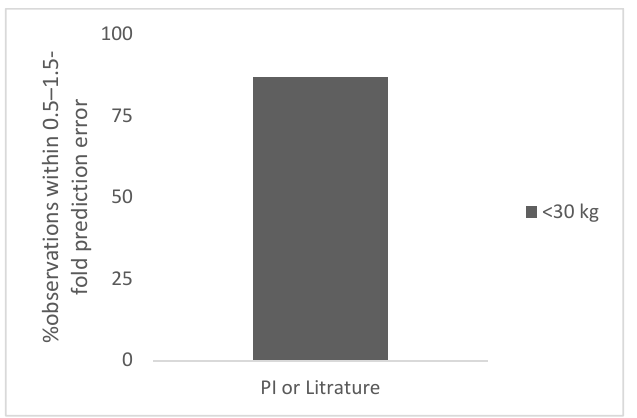
Figure 3. Percent observation within 0.5–1.5 ‐ fold prediction error for polyclonal antibodies in the neonates.